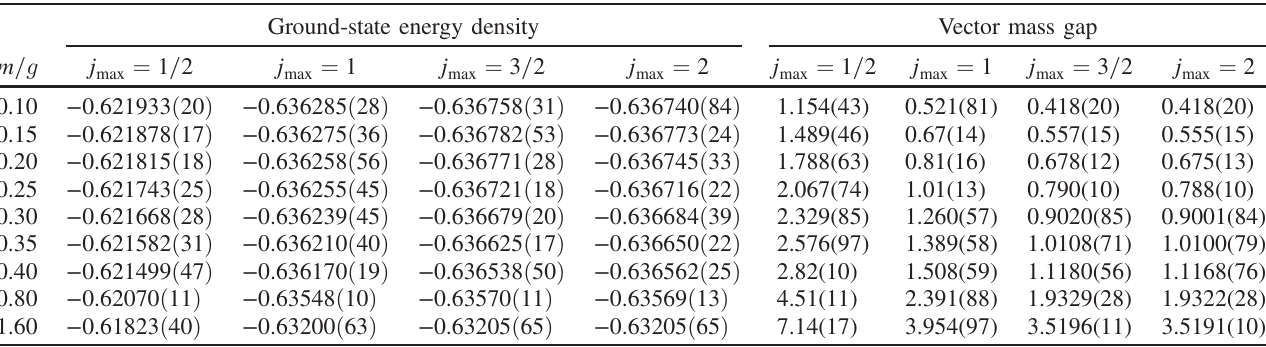
TABLE III. Ground-state energy densities and vector mass gaps obtained for various values for m=g and j sum in quadrature of the fitting uncertainty with a 1 σ confidence interval and the systematic